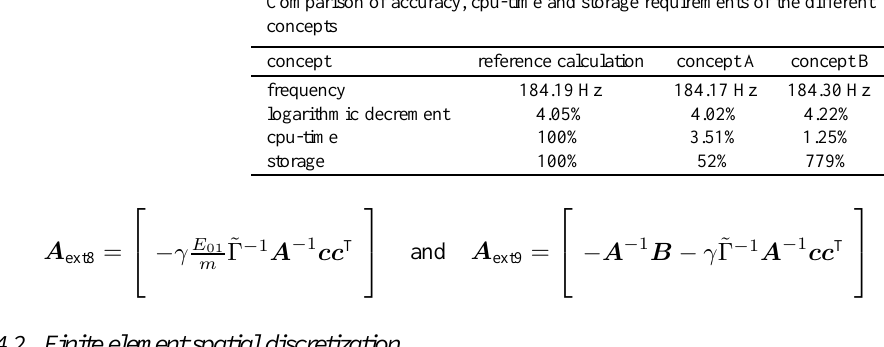
Table 2 Comparison of accuracy, cpu-time and storage requirements of the